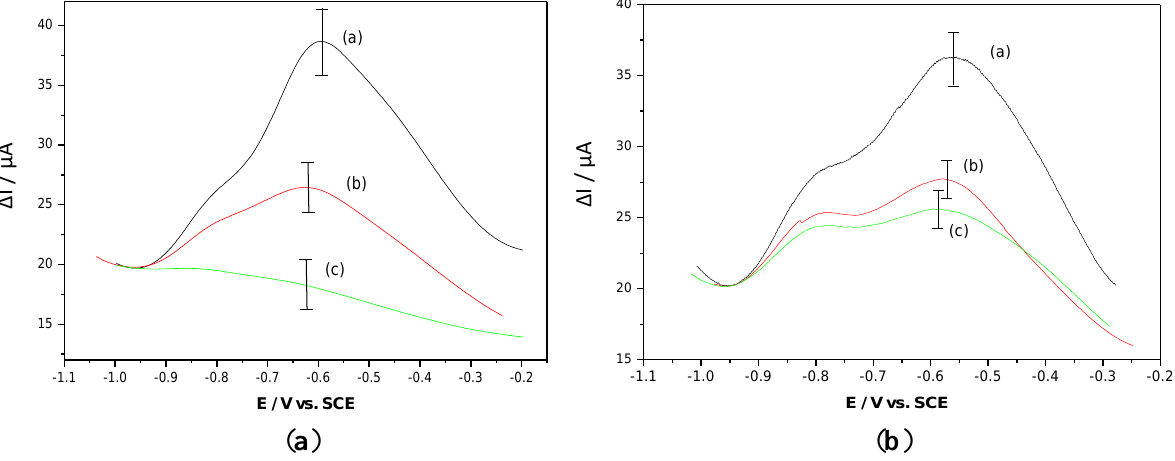
Figure 11. ( a ) SWV of a poly(HNQ-co-HSNQA) recorded in PBS before grafting (curve a), after grafting of 5 × 10 −8 M HPV-16-L1 (curve b) and after complexation with 5 × 10 −8 M -HPV (curve c). ( b ) SWV of a poly(HNQ-co-HSNQA) recorded in PBS before grafting (curve a), after grafting of 5 × 10 −8 M HPV-16-L1 (curve b) and after complexation with 5 × 10 −8 M -OVA (curve c) [42].